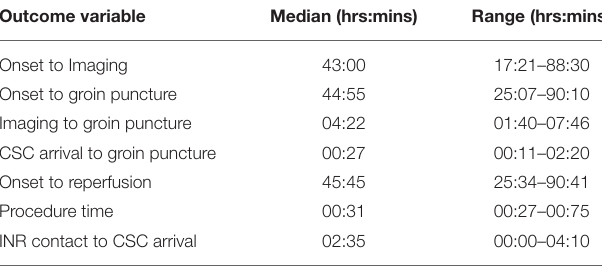
TABLE 2 | Time metrics.